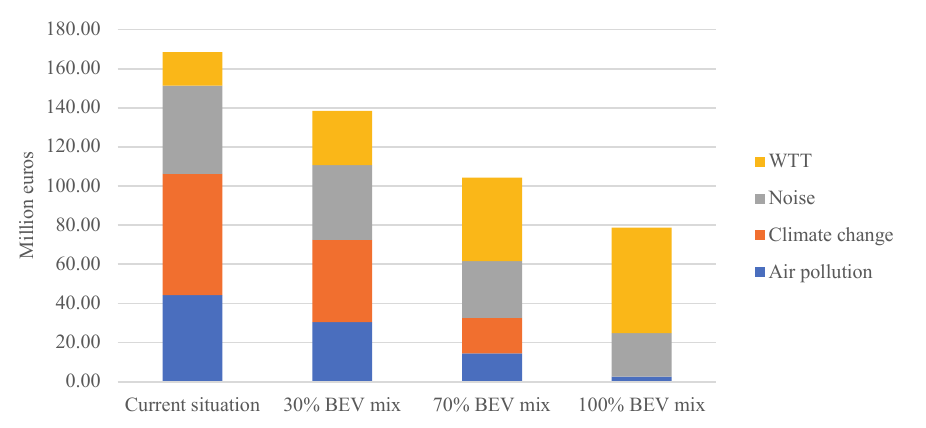
Fig. 6. Combined yearly external costs from passenger car and LCV fleet in Latvia with different BEV